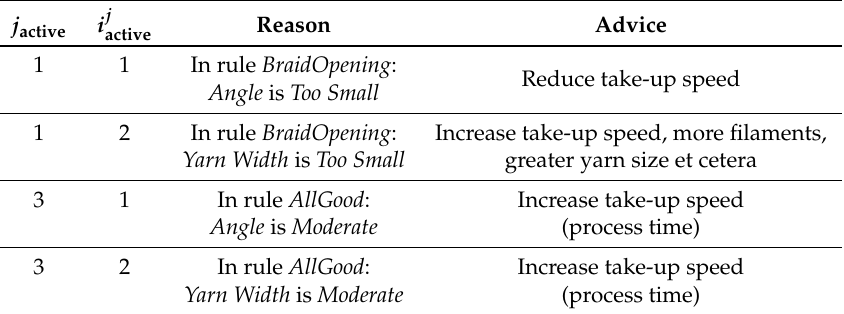
Table 1. Implemented reasons and advice for rules number one and